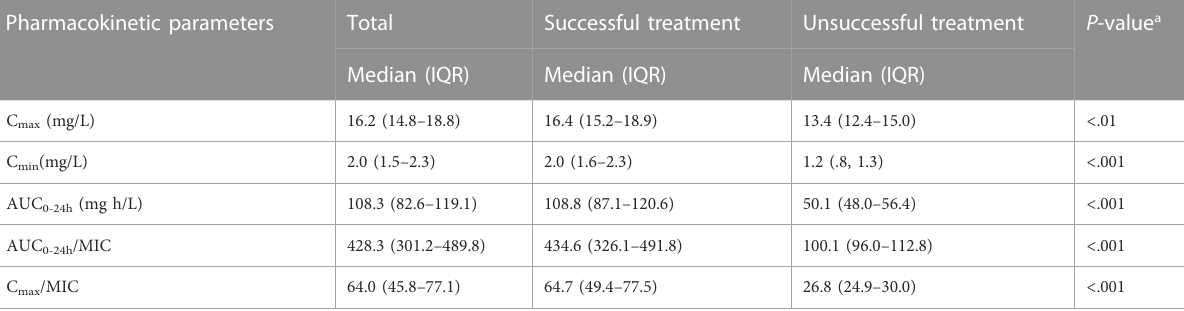
(Table 5). The association between the CART-derived threshold and fi nal treatment outcome/time to sputum culture conversion was well comparable to the previously reported target of 119 (Srivastava et al., 2017) (Figure 5).